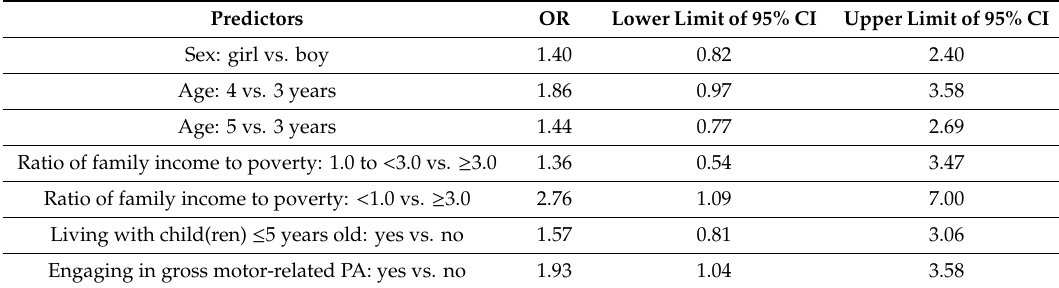
Table 3. Odds ratios of higher gross motor